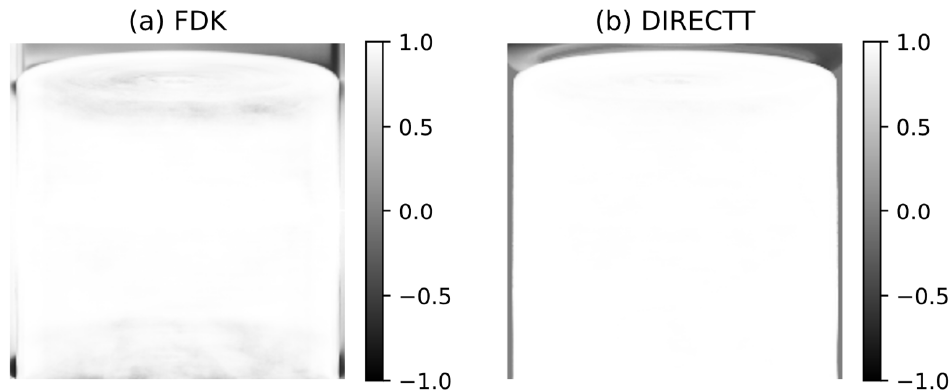
Figure 6. Pearson correlation coefficient between measured projections and simulated projections of the volumes reconstructed by: ( a ) FDK, and ( b ) Direct Iterative Reconstruction of Computed Tomography Trajectories (DIRECTT). The Pearson correlation coefficient (PCC) has been calculated for each detector pixel.